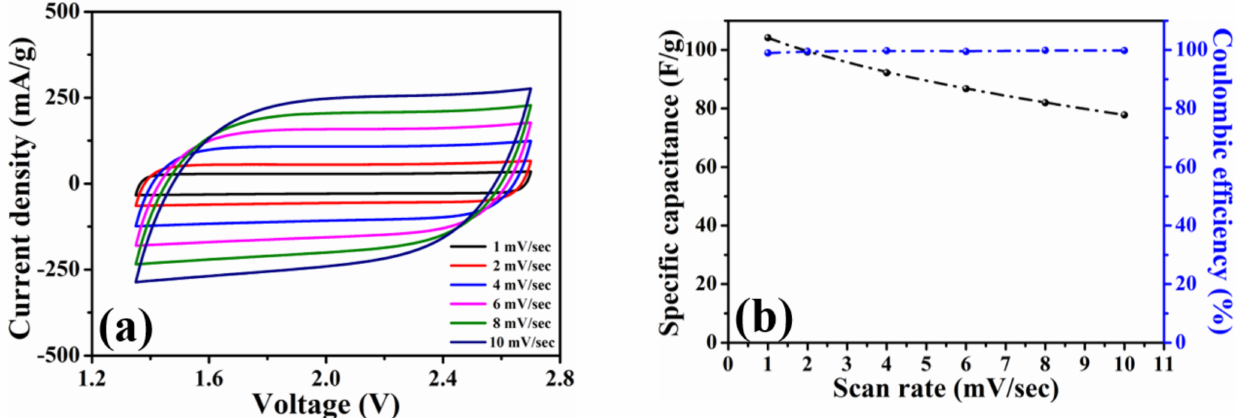
Figure 3. ( a ) Cyclic voltammograms and ( b ) average specific capacitances of a coin-type symmetric cell with high-mass loading hierarchically porous activated carbon electrodes recorded in 1.35–2.7 V at scanning rates from 1 to 10 mV/s.